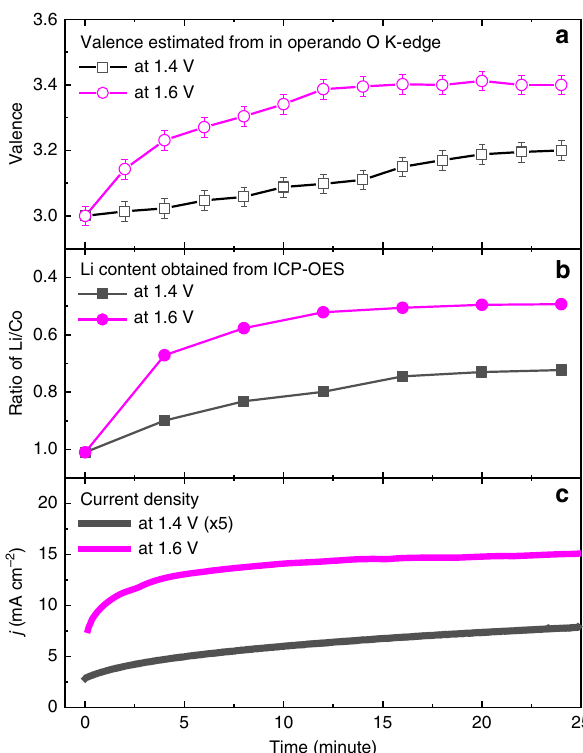
Fig. 3 Evolution of Li 2 Co 2 O 4 under applied voltages of 1.4 and 1.6 V over time. a Change in the Co valence determined from in operando SXAS, b evolution of the lithium/cobalt ratio, c evolution of current density j